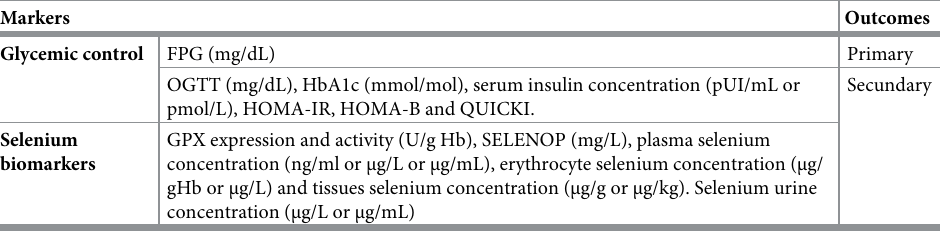
Table 2. Primary and secondary outcomes to be measured.